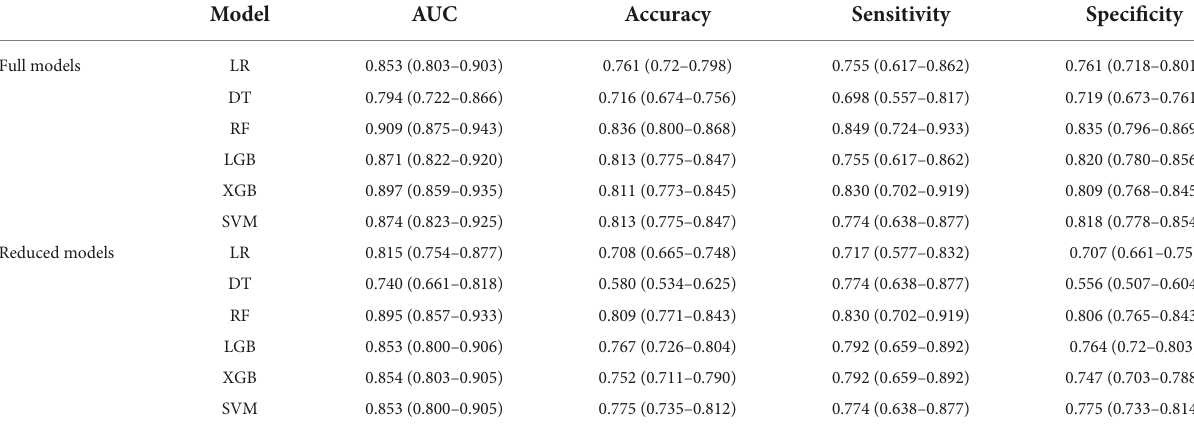
TABLE 2 The performance of each model.